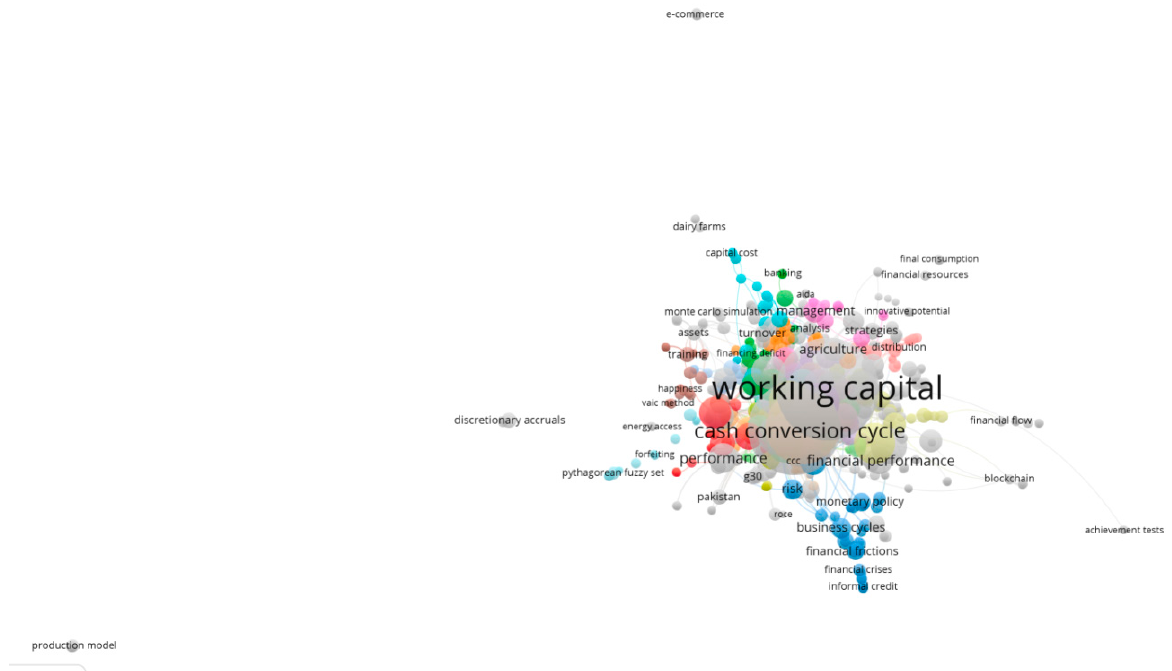
Figure 8. Co-occurrence links and author’s keywords, considering 1 as the minimum number of occurrences of a keyword and 1000 as the number of keywords selected.